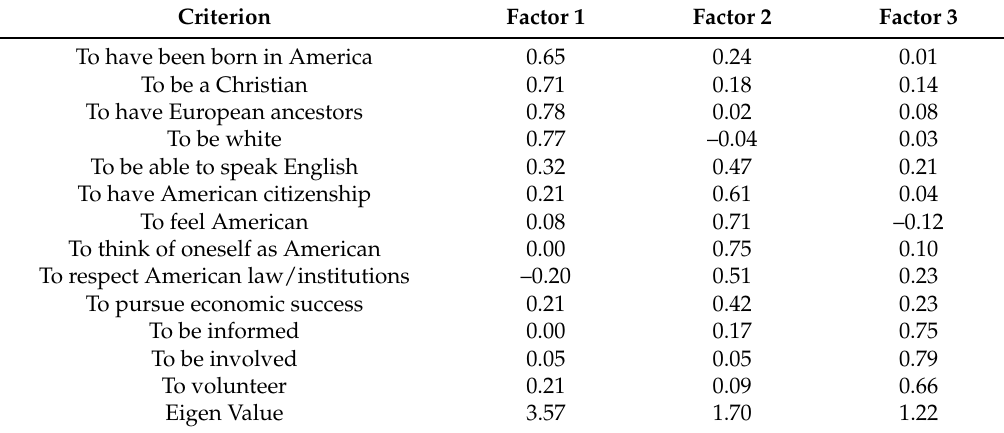
Table 1. Factor analysis